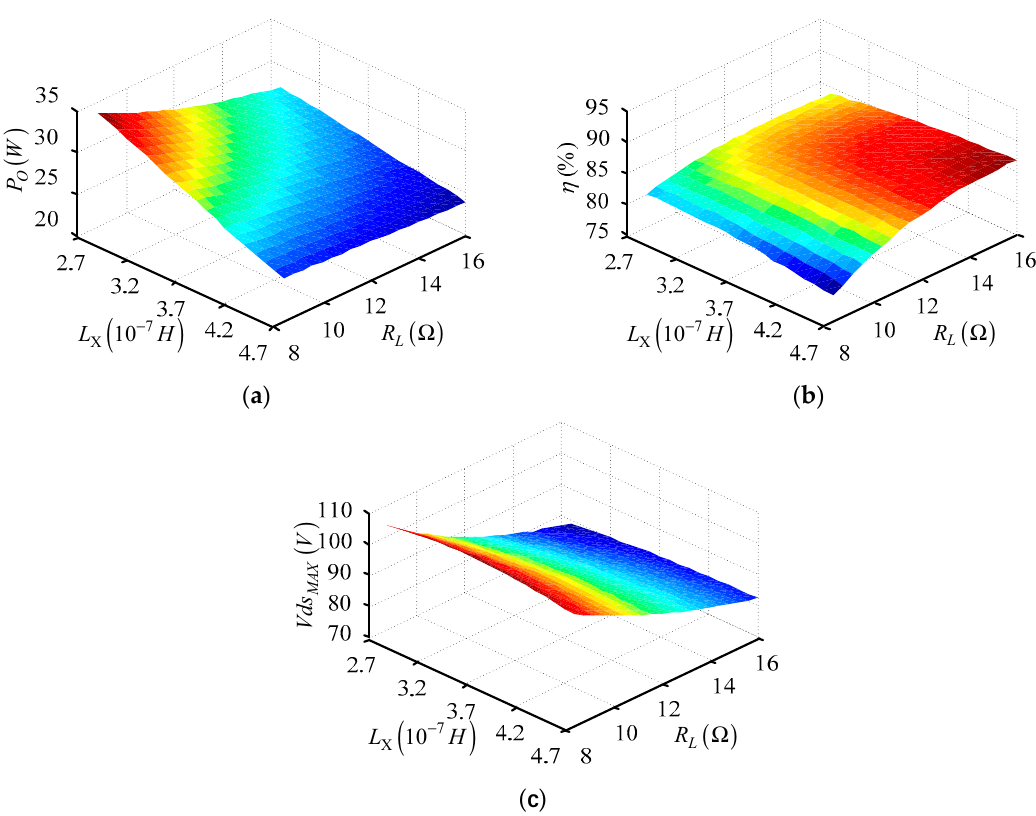
Figure 4. ( a ) Output power of RFC changing with L x and R L ; ( b ) output efficiency of RFC changing with L x and R L ; ( c ) peak voltage of RFC changing with L x and R L .